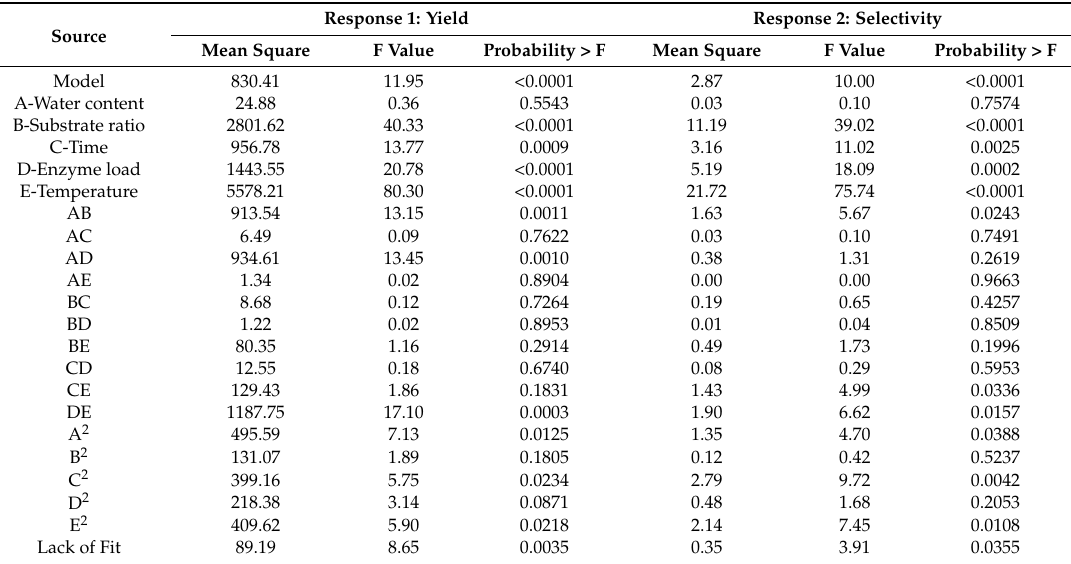
Table 2. Results of the regression analysis of the central composite design for PFA